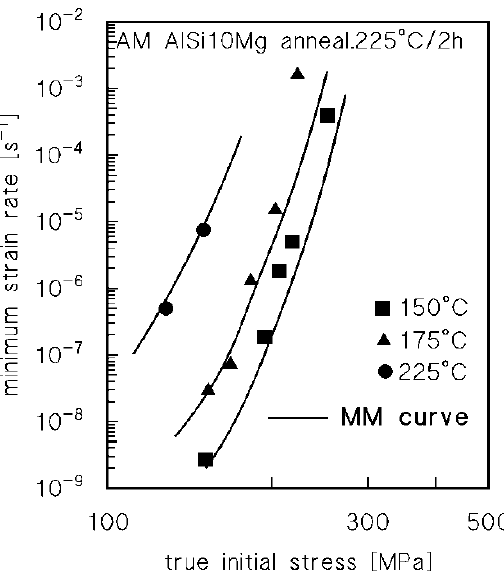
Figure 7. Model curves calculated for the material heat treated at 225 °C for 2 h. The only experimental datum used to calculate the curves is the relationship shown in Figure 4.